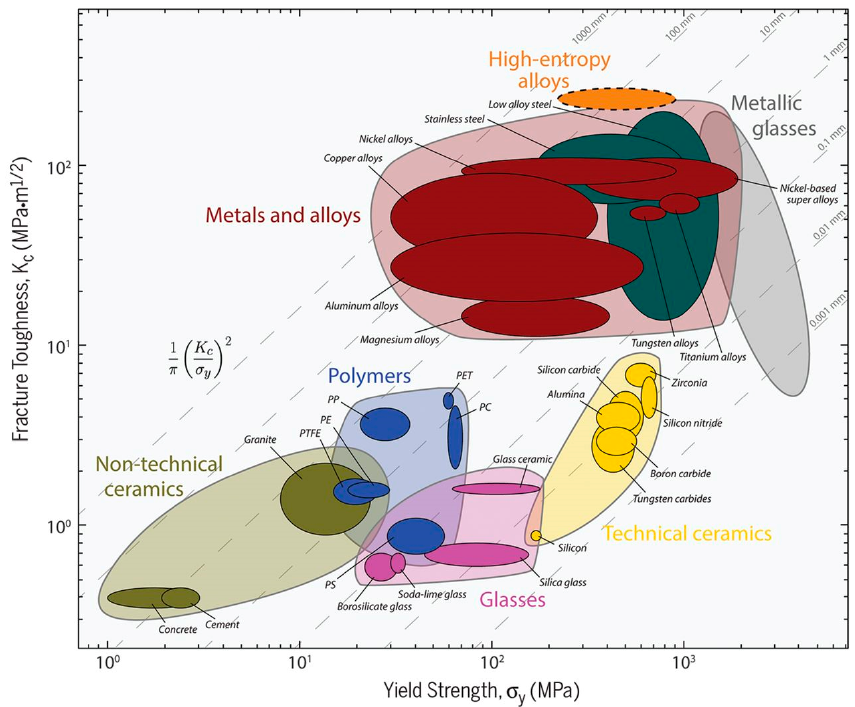
Figure 7. Fracture toughness as a function of yield strength for a wide variety of materials, including MPE alloys (high entropy alloys) (this figure is from Reference [86]).